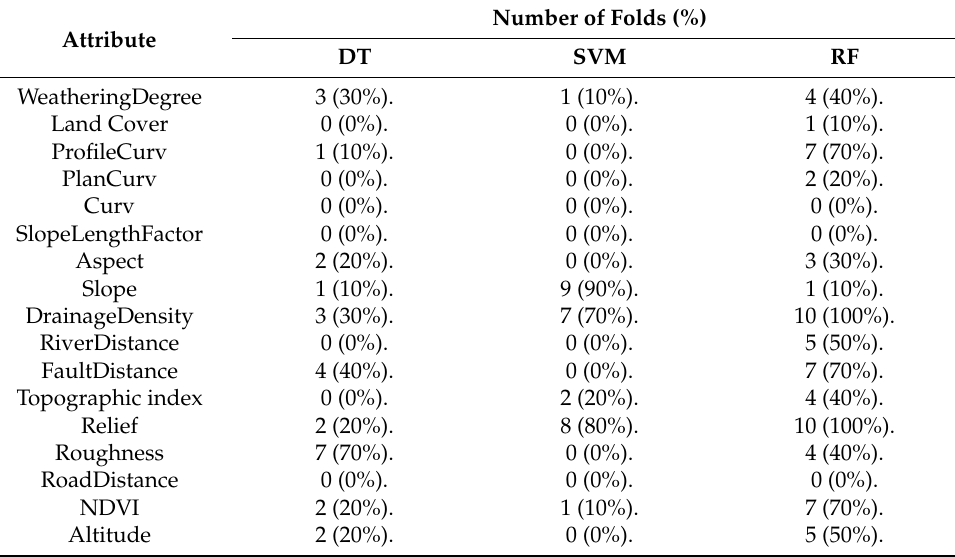
Table 5. Attribute selection 10-fold cross-validation (stratified) of DT, SVM and RF.